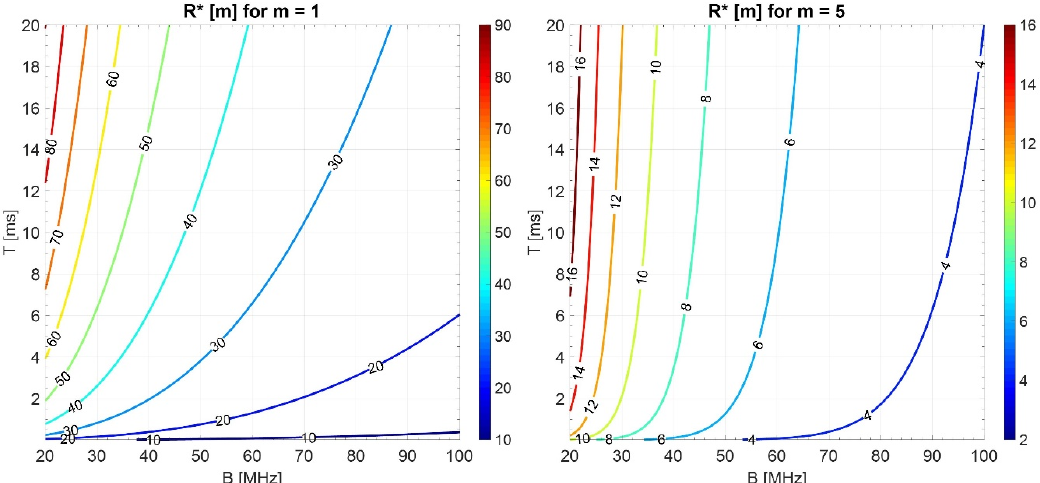
Figure 12. Level curves (in meters) of the transition Range R* varying B and T in the ideal case of flat spectrum (m = 0).